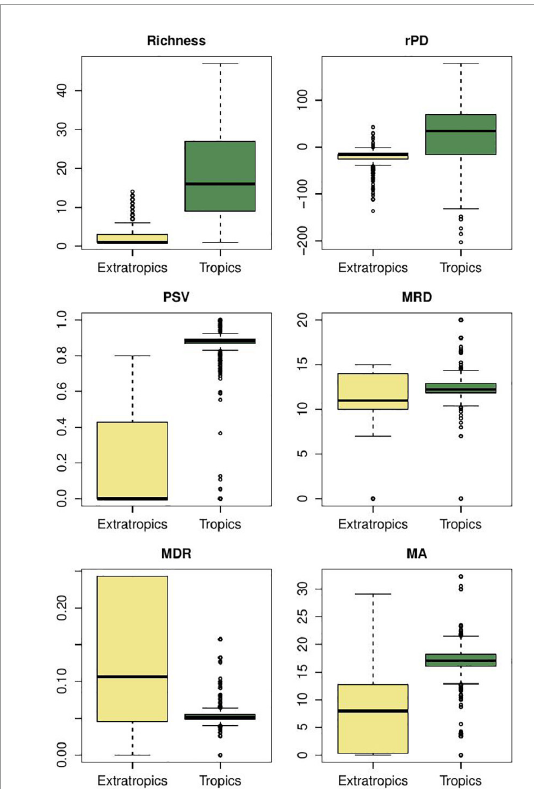
FIGURE5 Variation of phylogenetic metric values in Anolis lizards for continental and insular areas. rPD, residual phylogenetic diversity (i.e., after controlling for species richness); PSV, phylogenetic species variability; MRD, mean root distance; mDR, mean diversification rate; mAges, average ages of species. Y-labels correspond to the values of each metric. Comparisons of metrics between regions were evaluated using Bayesian ANOVAs and all were significant (Maximum A posteriori p -values < 0.001) except for PSV (Maximum A posteriori p -values >